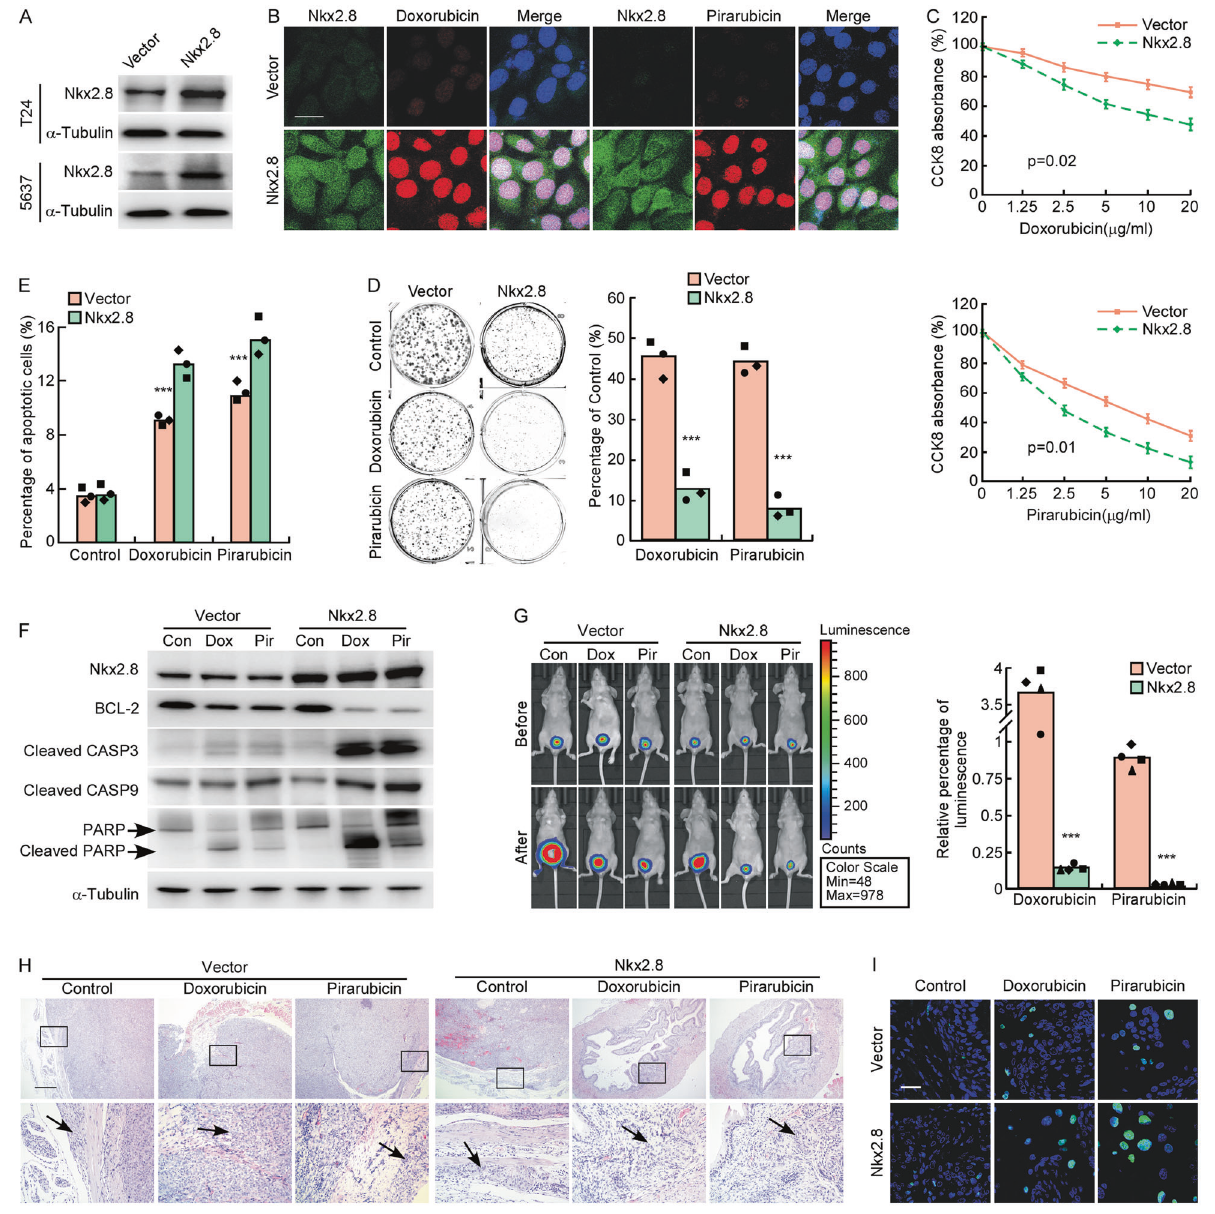
Fig. 2 Nkx2.8 enhances the chemosensitivity of UC cells in vitro and in vivo. A Western blot analysis of Nkx2.8 in Nkx2.8-overexpressed UC cells. B Immuno fl uorescence of Doxorubicin and Pirarubicin density in T24 with vector or Nkx2.8 overexpressed. Nuclear DNA was stained with DAPI. Scale bar, 20 μ m. C CCK8 analysis of vector or Nkx2.8 overexpressed T24 after treated by different dose of Doxorubicin (upper) or Pirarubicin (lower) (mean ± SD). p values are indicated (two-tailed t test, n = 3). D Colony formation assays of vector cells or Nkx2.8 overexpressed T24 after treated by Doxorubicin or Pirarubicin (left panel) and quanti fi cation (right panel) of colonies (mean ± SD). *** p < 0.0001 (two-tailed t test, n = 3). E The apoptosis rate of vector cells or Nkx2.8 overexpressed T24 after treated by Doxorubicin or Pirarubicin (mean ± SD). *** p < 0.0001 (two-tailed t test, n = 3). F Western blot analysis of apoptotic markers in T24 with vector or Nkx2.8 overexpressed after treated by Doxorubicin or Pirarubicin. G Representative images of macroscopic orthophoric bladder urothelial cancer generated from vector or Nkx2.8 overexpressed T24s before or after treated with Doxorubicin (Dox) or Pirarubicin (Pir) (left panel). Quanti fi cation of luminescence in orthophoric bladder urothelial cancer (right panel) mean ± SD. *** p < 0.0001 (two-tailed t test, n = 4). H Representative images of H&E staining. Scale bar, 500 μ m. I TUNEL assay of apoptosis in tumor tissues. Scale bar, 20 μ overexpressed cells (Figs. 2F and S1E). These in vitro data suggested that drug sensitivity of UC cells signi fi cantly increased after overexpressed with Nkx2.8. (Figs. 2E and S1D). We also detected the expression of some Next, the in vivo effects of Nkx2.8 on drug sensitivity were apoptotic markers by Western blotting analysis. Our results evaluated. We constructed orthotopic xenograft UC model by showed that after treated with Doxorubicin or Pirarubicin, the intravesical instilling T24/Nkx2.8 cells or T24/vector cells, which expression levels of the apoptosis markers, such as cleaved- were transfected with luciferase, into nude mice urinary bladder. caspase3, cleaved-caspase9 and cleaved-PARP were upregulated, After 7 days, Doxorubicin (5 mg/kg) or Pirarubicin (5 mg/kg) were the expression of BCL-2 was downregulated in Nkx2.8-